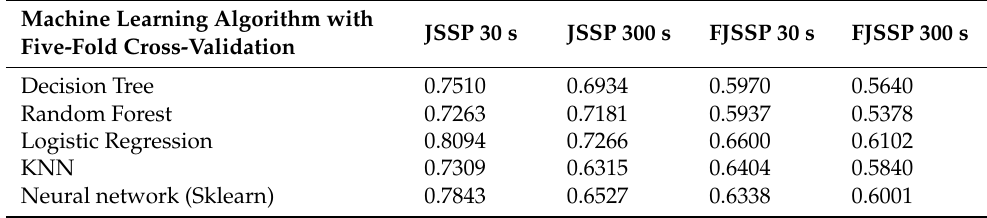
Table 10. Five-fold cross-validation of mean validation accuracy results.